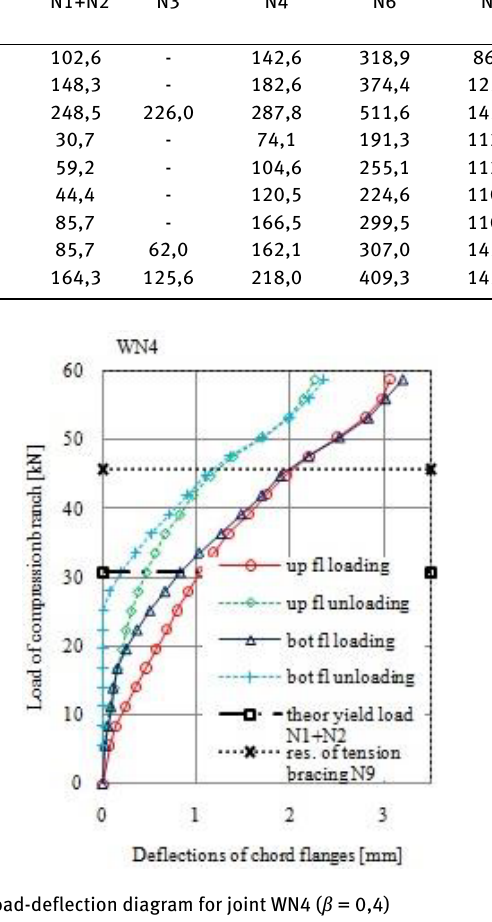
Table 2: Theoretical resistances of joints Specimen